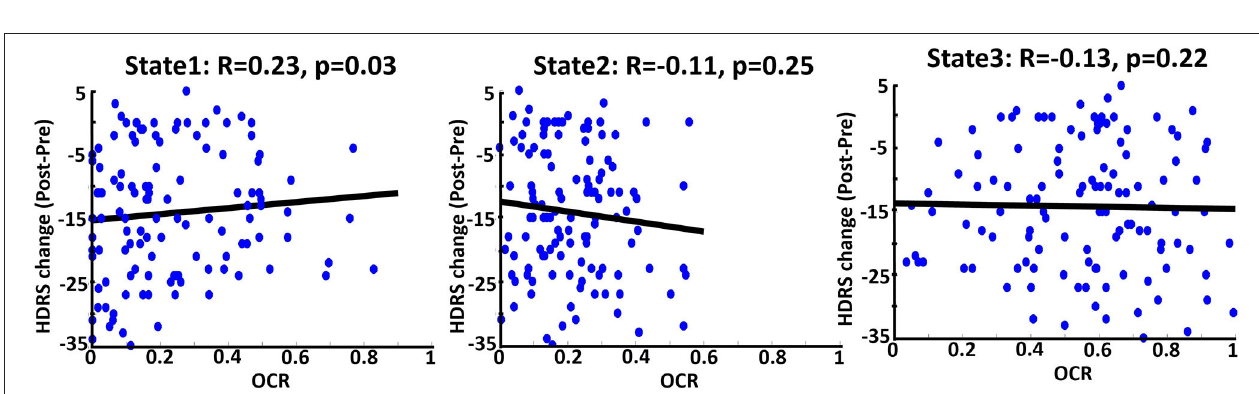
FIGURE 4 | Correlation between OCR values from just pre-ECT and reported HDRS change (Pre-post) in three states. Blue dots are referred to 119 DEP individuals. The bold black line is the fitted curve. R indicates the fitted line slope in each state. As it is shown, state 1 (the state with the lowest CCN/DMN connectivity) significantly predicts the change of the HDRS based on OCR values; less OCR value corresponds to more change of HDRS.